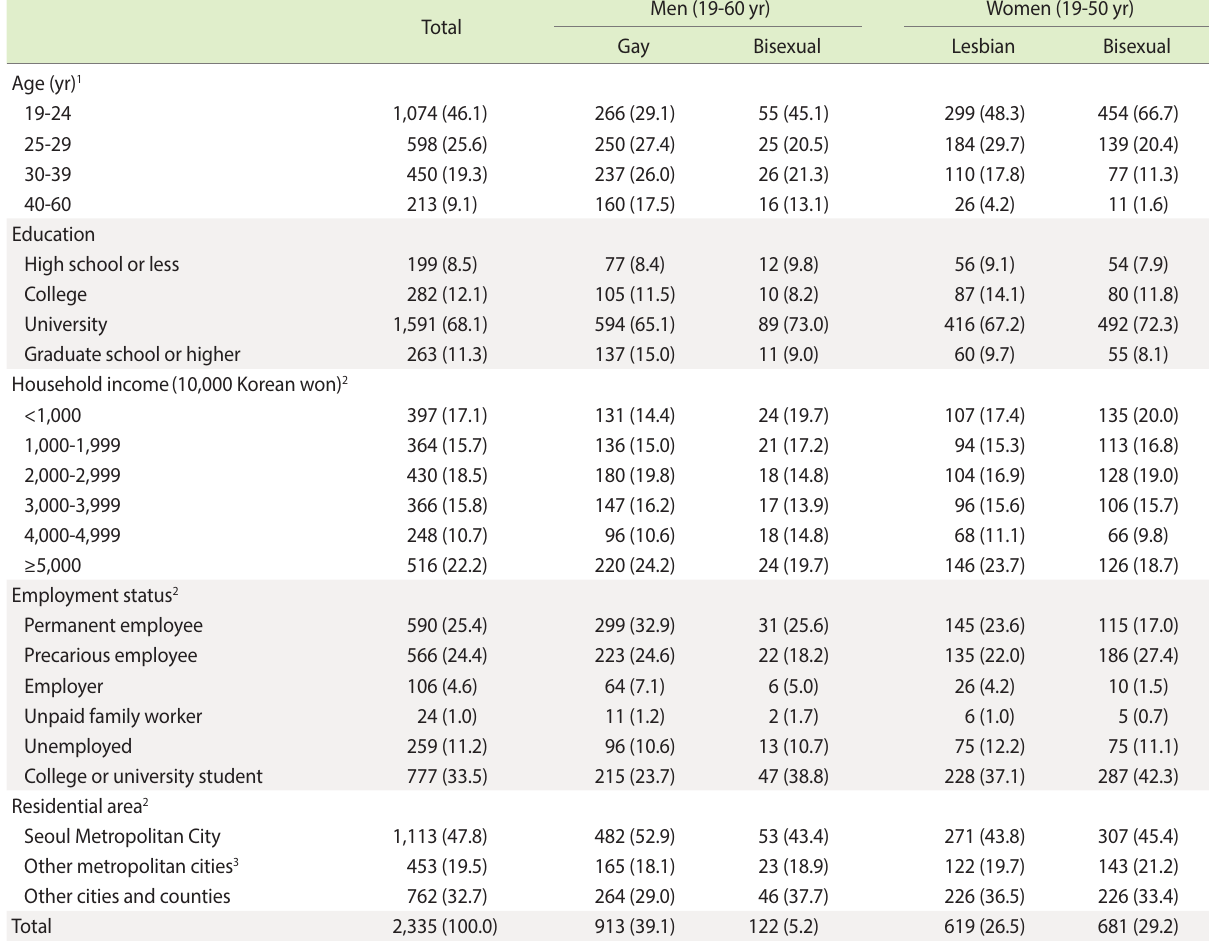
Table 1. Socio-demographic characteristics of participants by gender and sexual orientation